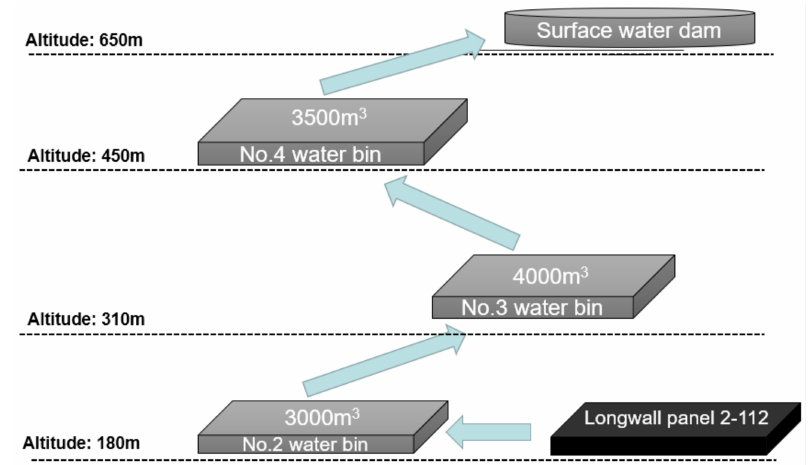
Figure 1. Layout of the multi-level water bins.